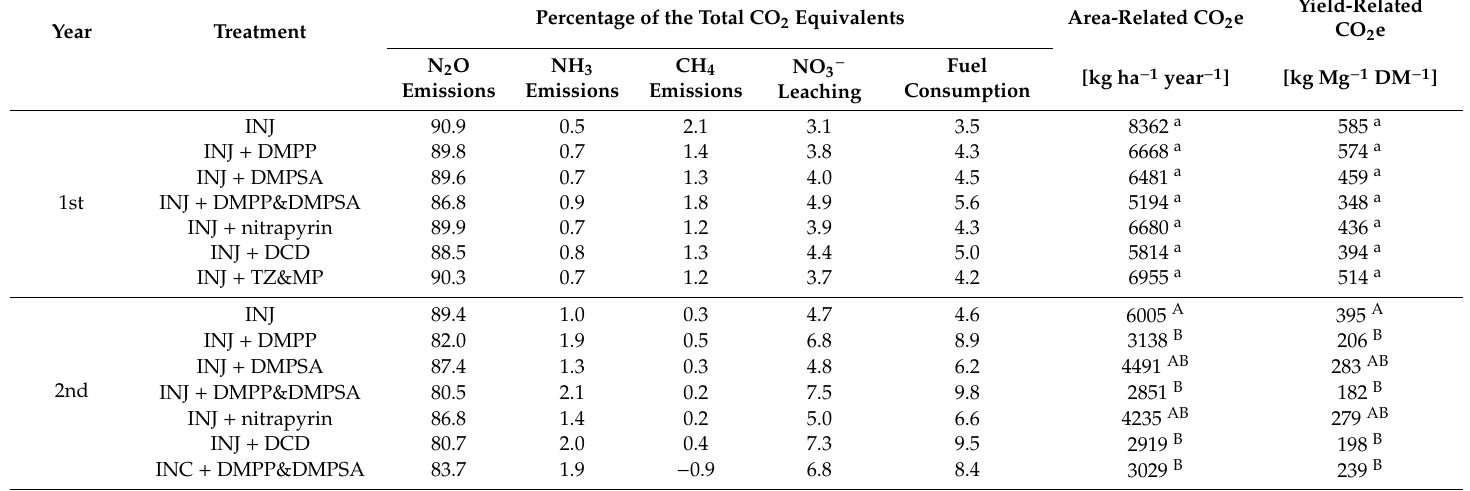
Table 3. Mean greenhouse gas (GHG) emissions as a ff ected by treatment (slurry injection (INJ) without NI (nitrification inhibitor) and with DMPP (INJ + DMPP), DMPSA (INJ + DMPSA), with the combination of DMPP&DMPSA (INJ + DMPP&DMPSA), with nitrapyrin (INJ + nitrapyrin), with DCD (INJ + DCD), with TZ&MP (INJ + TZ&MP) and the slurry incorporation treatment (INC) with the combination of DMPP&DMPSA (INC + DMPP&DMPSA)) and experimental year as CO 2 equivalents (CO 2 e) calculated from field-related direct N 2 O, CH 4 , and NH 3 emissions, NO 3 − leaching, and fuel consumption. Di ff erent superscript letters indicate statistically significant di ff erences between treatments within the same year and column (Kruskal-Wallis ANOVA on Ranks for dataset from 1st